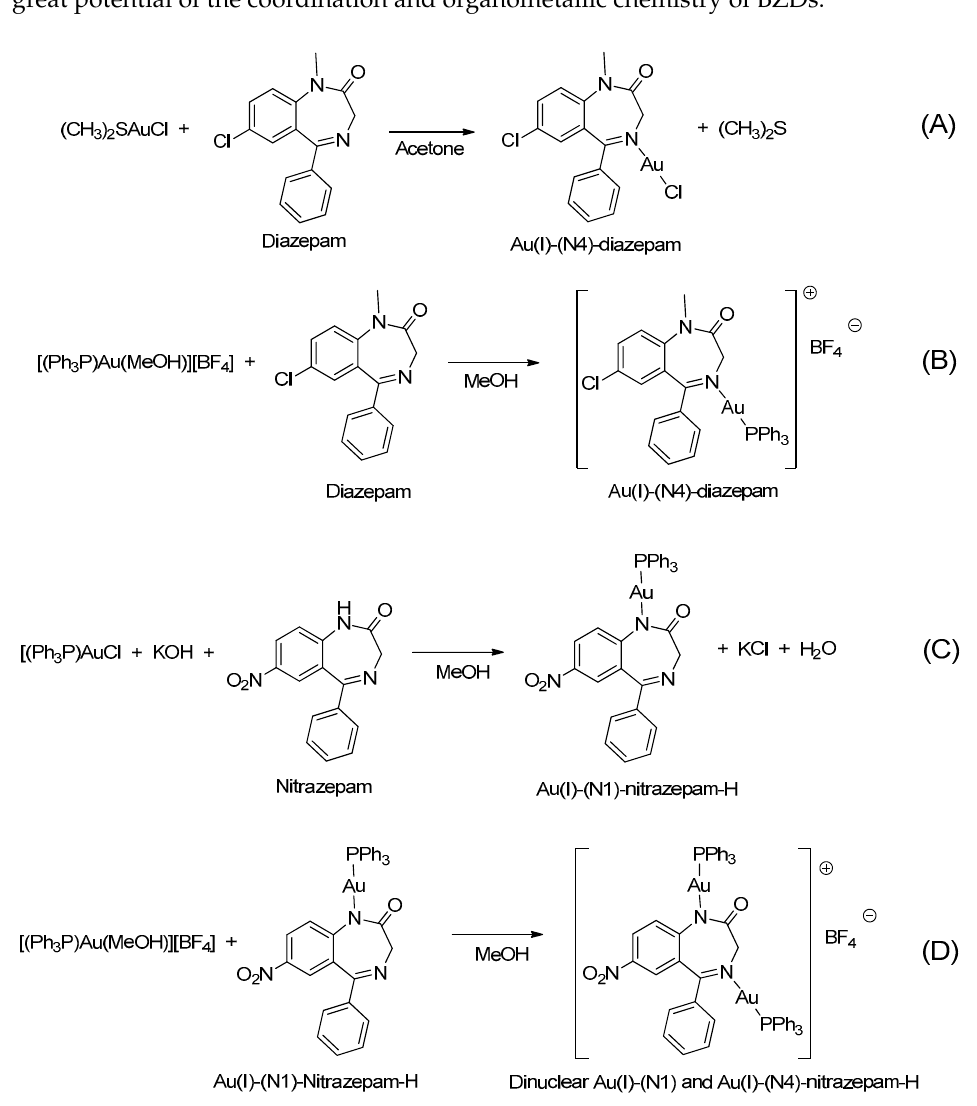
Figure 5. A series of BZD-Au(I) derivatives prepared by Cinellu and coworkers ( A – D